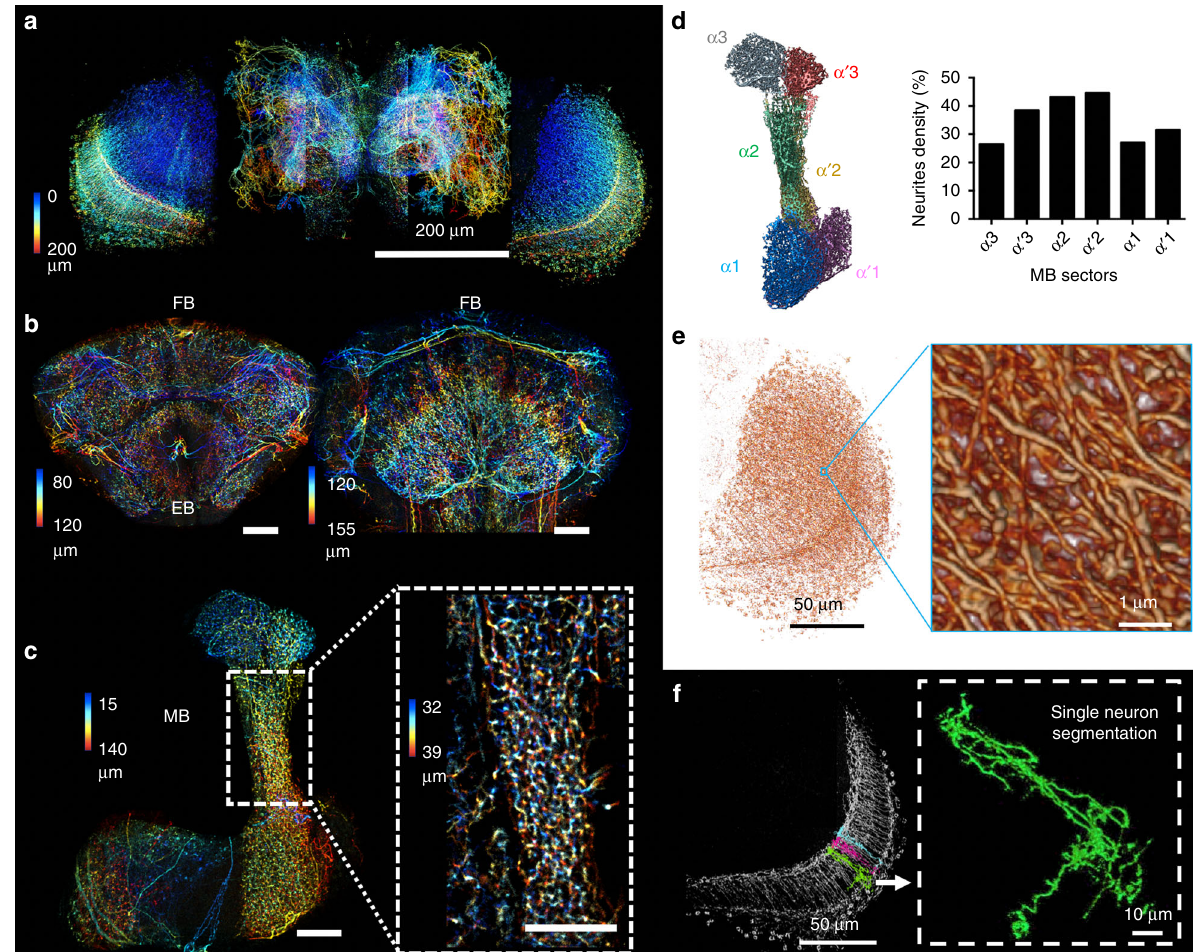
Fig. 5 LLM-CT imaging of all dopaminergic neurons in D. melanogaster brain. a A whole-brain super-resolution mapping of all dopaminergic neurons labeled by HMSiR via anti-green fl uorescent protein immunostaining in TH-Ga l4 > UAS-GC aMP6f fl ies. b Maximum intensity projection of several optical slices showing dopaminergic innervations in the ellipsoid body (EB) and fan-shaped body (FB). c Dopaminergic innervations in the mushroom body (MB). Inset: magni fi ed view of the optical slices at the α 2 α ’ 2 sector of the MB vertical lobe. The colors indicate different depths beneath the surface. Scale bars = 20 µ m, unless otherwise indicated. d Super-resolved dopamine neuron fi ber density distribution in each sector of the MB. e Volume rendering of whole- brain dopaminergic neurons. Zoomed-in images show distinguishable interweaved neurites. f Digital segmentation of local neurons in the medulla. Inset: enlarged green neuron. The experimental fl ies carried TH-Gal4 ; UAS-GCaMP6f